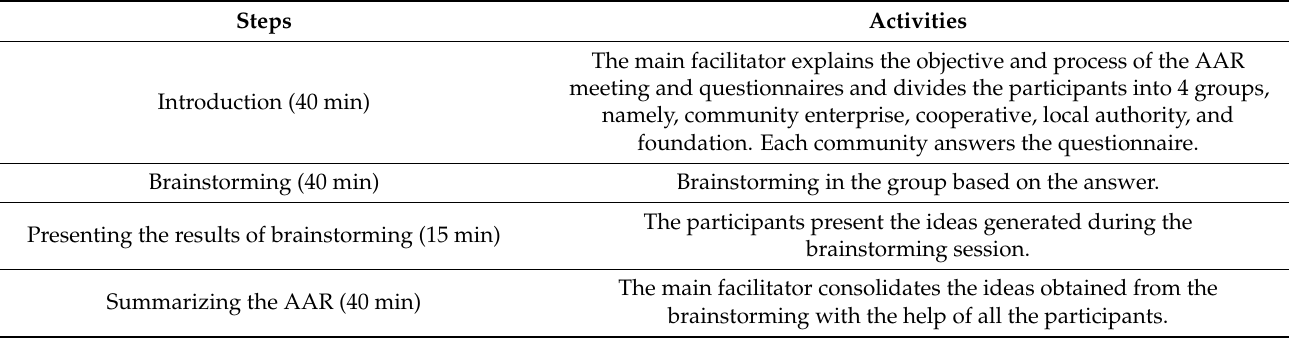
Table 2. The AAR